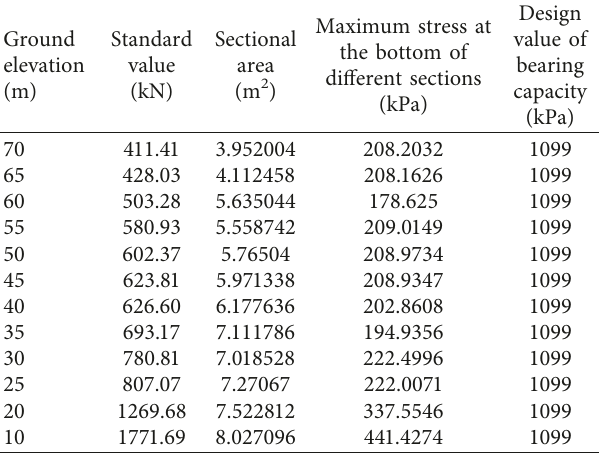
Table 6: Shear stress under the action of wind. Ground